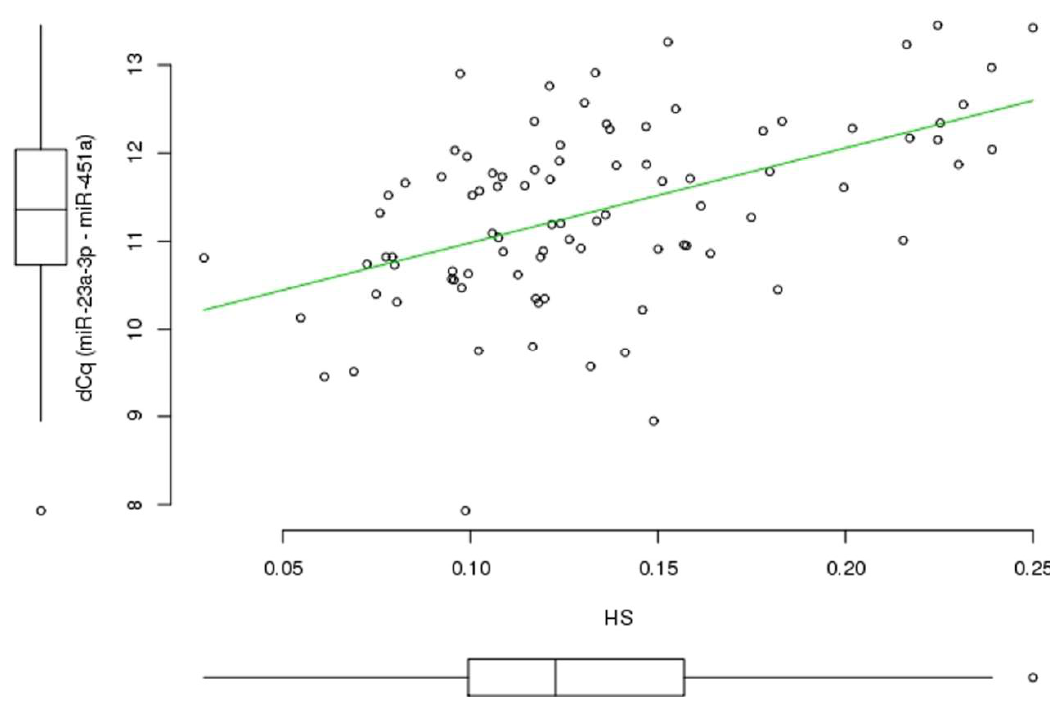
Figure 2. dCq (miR-23a-3p–miR-451a) and HS values in plasma samples of 90 study participants. HS: hemolysis score; dCq (miR-23a-3p–miR-451a): Cq difference between miR-23a-3p and miR-451a. The boxplots near the x- and y-axis represent the median and interquartile ranges (IQR) in the box, minimum and maximum values in the “whiskers”, and outliers in the dots.